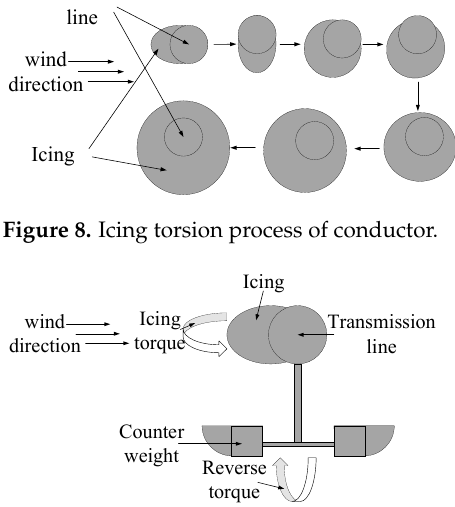
Figure 9. Schematic diagram of the torque pendulum.